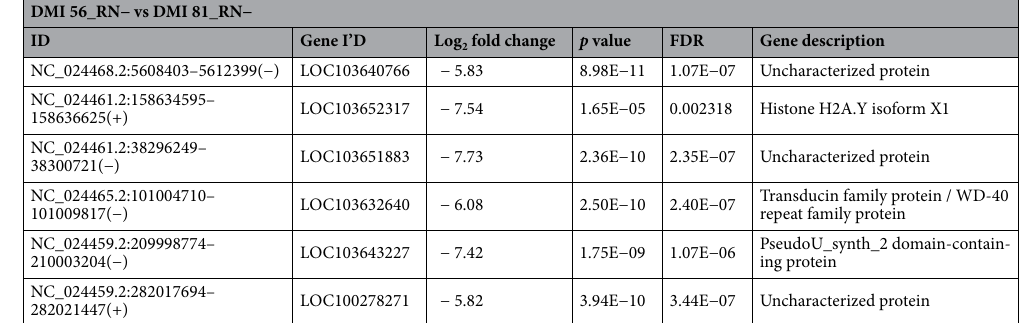
Table 3. Selected top 20 up- and down-regulated genes in DMI 81 root as compared to DMI 56 root under low-nitrogen stress (DMI 56_RN− vs DMI 81_RN−) using EdgeR. Letters R, and N- represent root, and nitrogen-deficiency conditions,